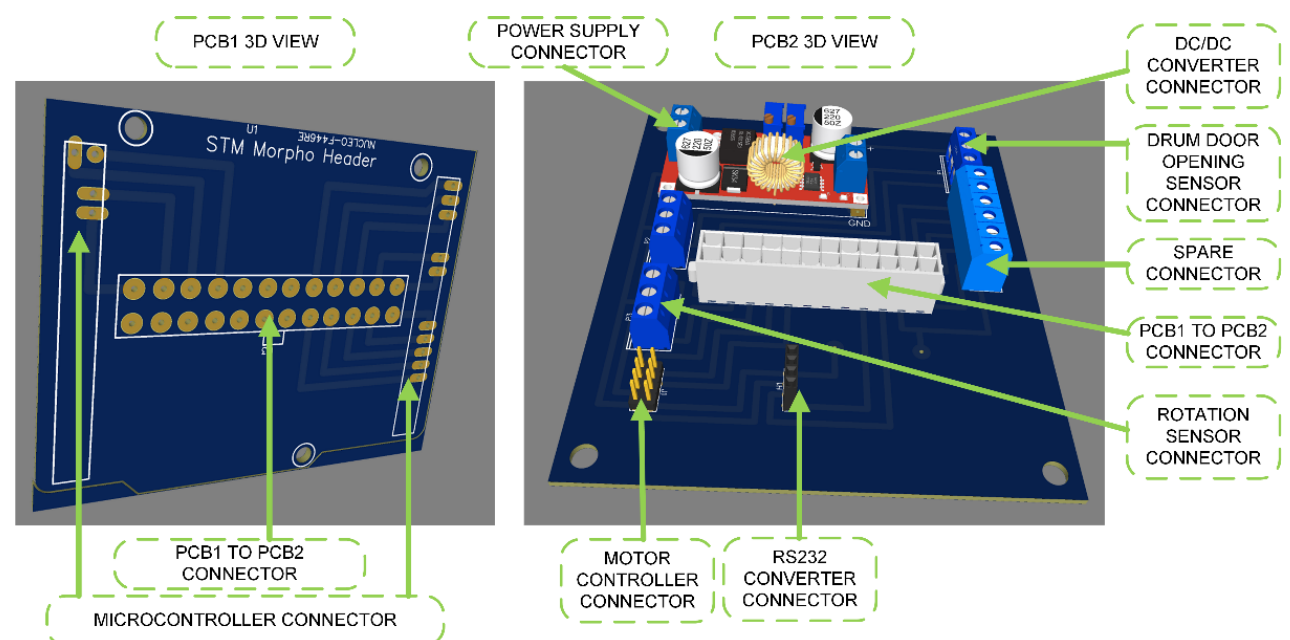
Figure 6. PCB1 and PCB2 layouts.